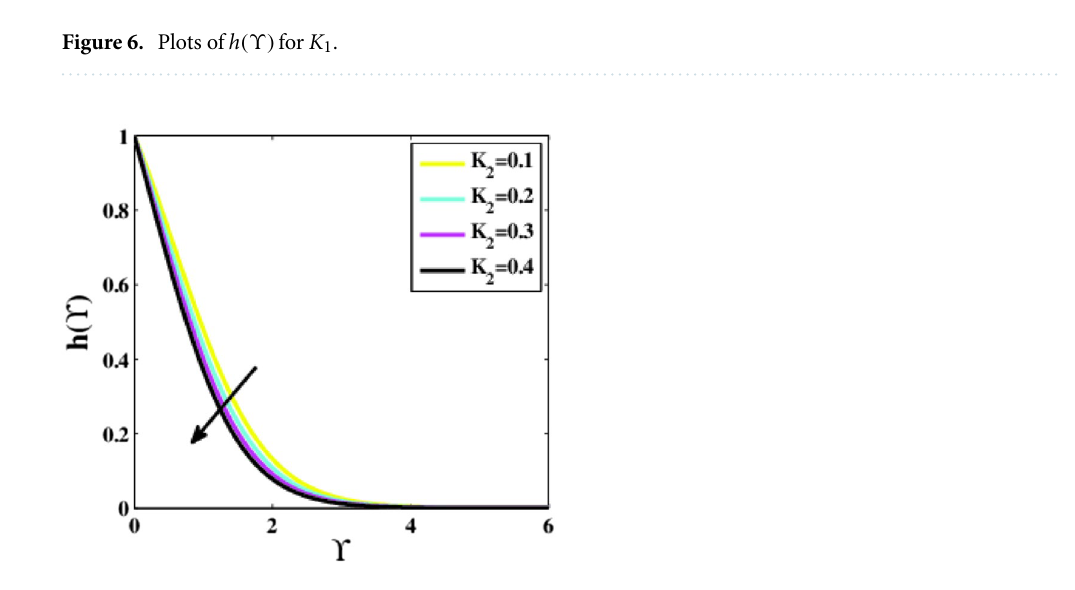
Figure 7. Plots of h (ϒ) for K 2